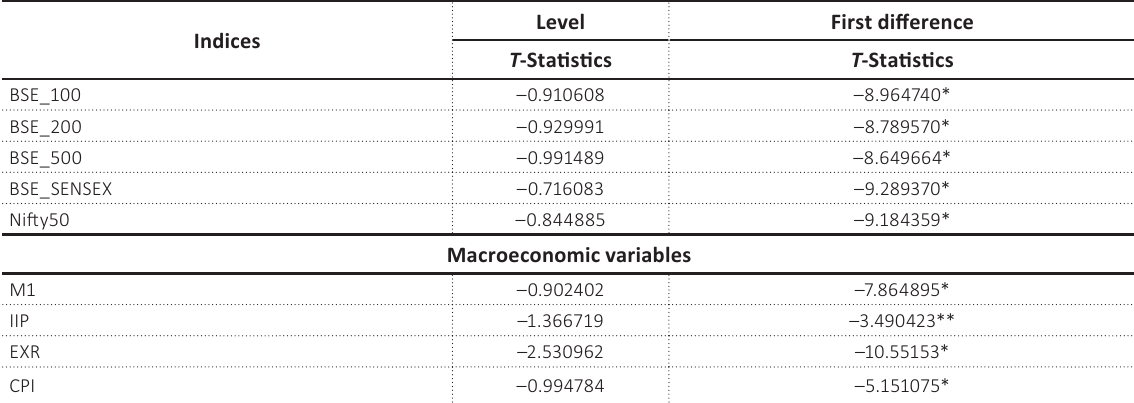
Table 3. ADF unit root test for variables for 2013–2019